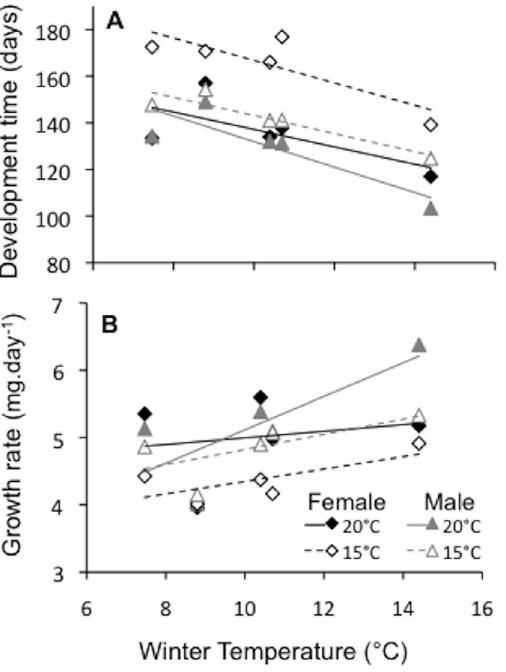
Figure 4. Adaptation of growth and development to local conditions. Regressions of laboratory measured (a) development and (b) growth rates of H. merope larvae with respect to average winter temperature (May – September) of source populations. Male and female data for the two temperature treatments are indicated.